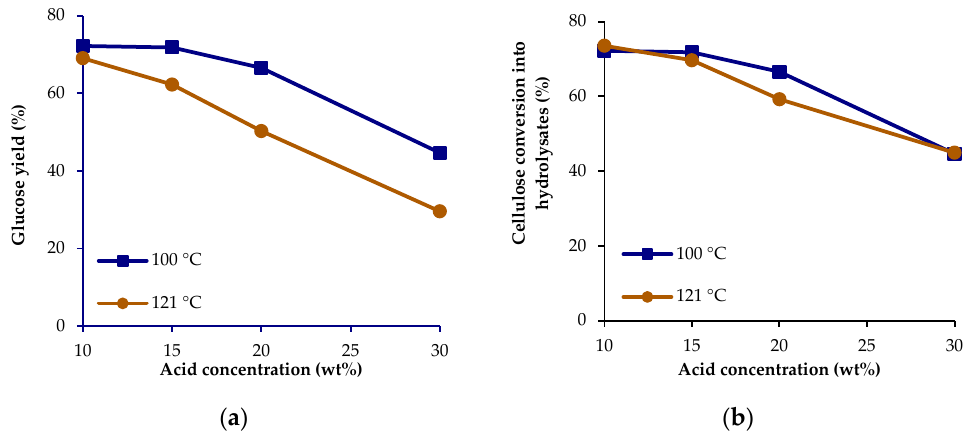
Figure 3. Glucose yield ( a ) and conversion of cellulose into hydrolysates ( b ) obtained with different combinations of sulfuric acid concentration and temperature in the post-hydrolysis step.